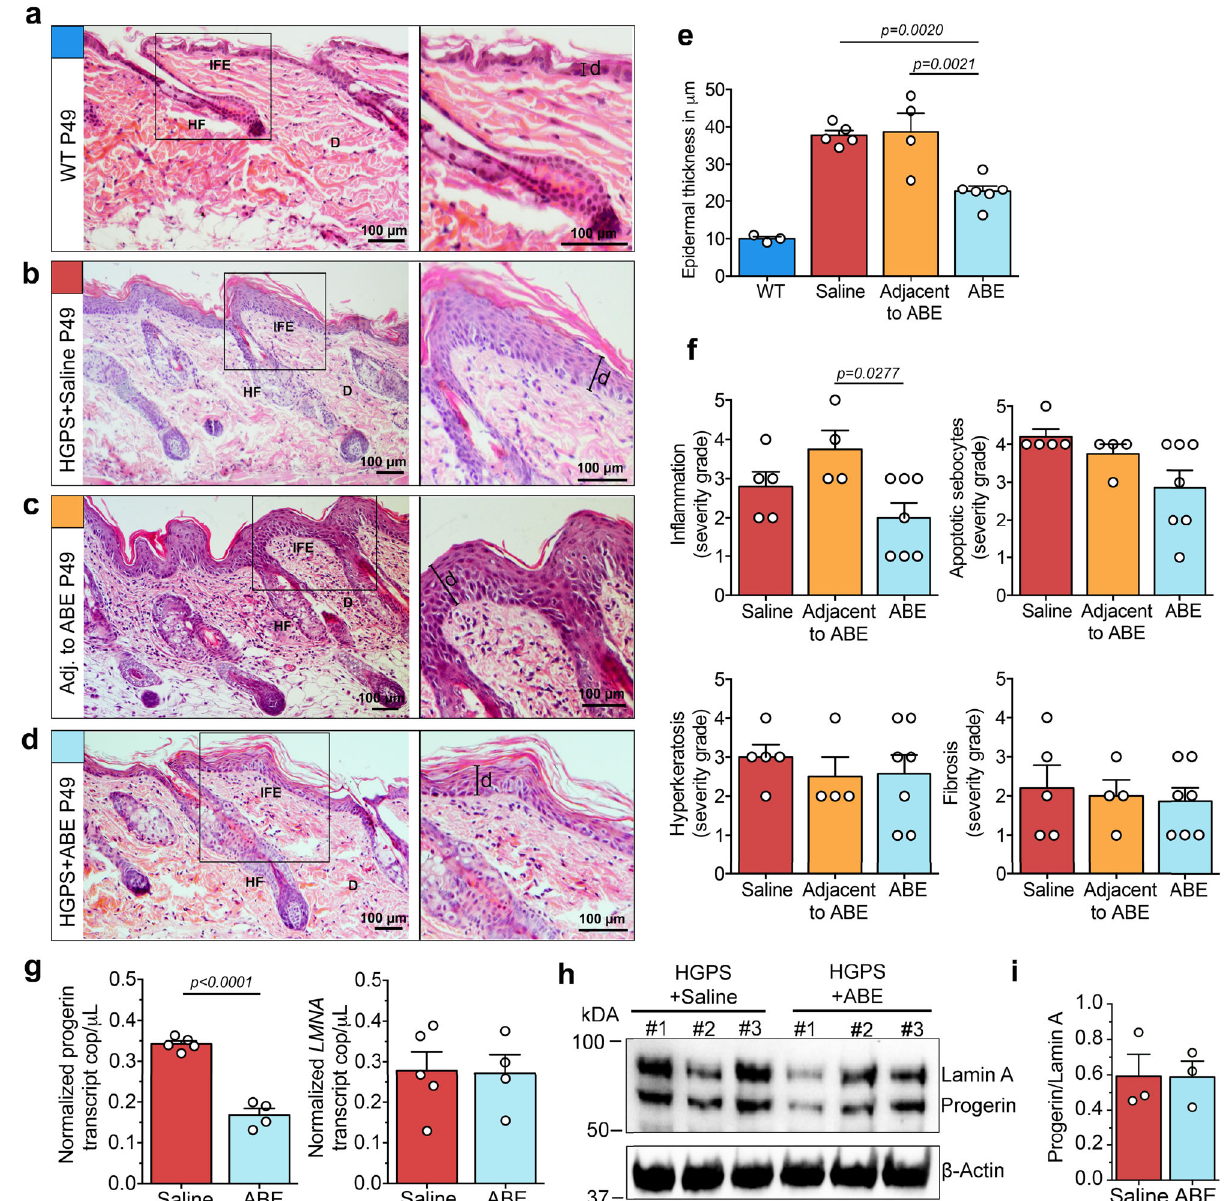
Fig. 3 Long-term improvements of HGPS mouse skin pathology after LF-ABE treatment. a – d Skin from wild-type mice (WT, n = 3 independent experiments with similar results) and saline ( n = 5, independent experiments with similar results), uninjected adjacent skin sites ( n = 4, independent experiments with similar results) or LF - ABE ( n = 6, independent experiments with similar results) treated HGPS mice was collected at seven weeks of age (P49) and H&E-stained for histopathological analysis (Interfollicular epidermis, IFE; hair follicle, HF; dermis, D, scale bar: d = 100 μ m). e Graph showing the signi fi cant reduction of the epidermal thickness (indicated as d ) in LF-ABE treated ( n = 6 biologically independent sample) vs. saline-treated HGPS ( n = 5 biologically independent samples, p = 0.0020) and uninjected adjacent skin sites ( n = 4 biologically independent samples, p = 0.0021). f Graphs showing the histopathological assessment by severity grading (1 = minimal, 2 = mild, 3 = moderate, 4 = marked, 5 = severe) of in fl ammation (Adjacent to ABE compared to ABE, p = 0.0277), apoptotic sebocytes, hyperkeratosis and fi brosis in LF-ABE ( n = 7 biologically independent samples), saline-treated HGPS mice ( n = 5 biologically independent samples) and uninjected adjacent skin sites ( n = 4 biologically independent samples). g Absolute quanti fi cation (ddPCR-ABS) was used to measure progerin (Saline compared to ABE, p < 0.0001) and lamin A transcript levels in LF-ABE ( n = 4 biologically independent samples) and saline-treated HGPS mouse skin ( n = 5 biologically independent samples) four weeks post-treatment. h , i Western blot analysis of progerin abundance ( n = 3 biologically independent samples, #1 – 3 for each LF-ABE treated and saline treated group). WT samples are depicted in blue, uninjected adjacent skin sites are depicted in yellow, saline-treated samples are depicted in red LF-ABE treated samples are depicted in light blue. Data are represented as mean values + / − SEM. e , f P values were calculated by one-way ANOVA, adjusted for multiple comparisons, 95% CI. g P value was calculated by two-tailed unpaired t test, 95% CI. For ( e – i ) data are provided as a Source Data fi